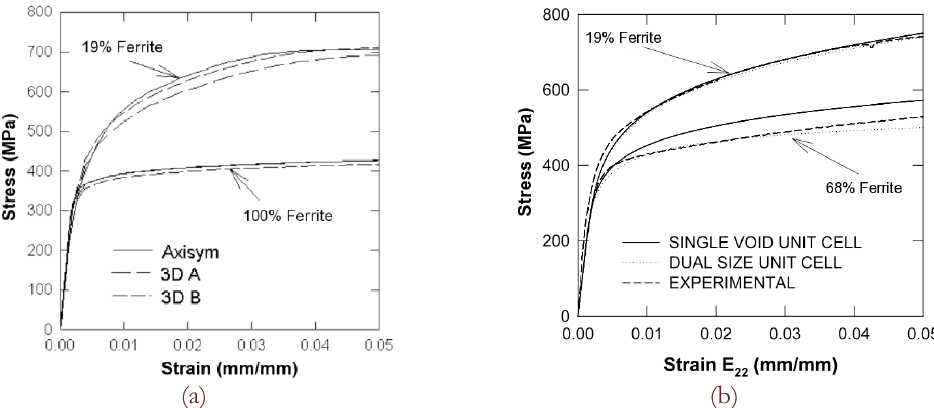
Figura 9: (a) risposta della ghisa nodulare simulata con modelli di cella assialsimmetrica e tridimensionale (modelli 3D A e 3D B); (b) effetto della modellazione a cella assialsimmetrica con doppia cavità